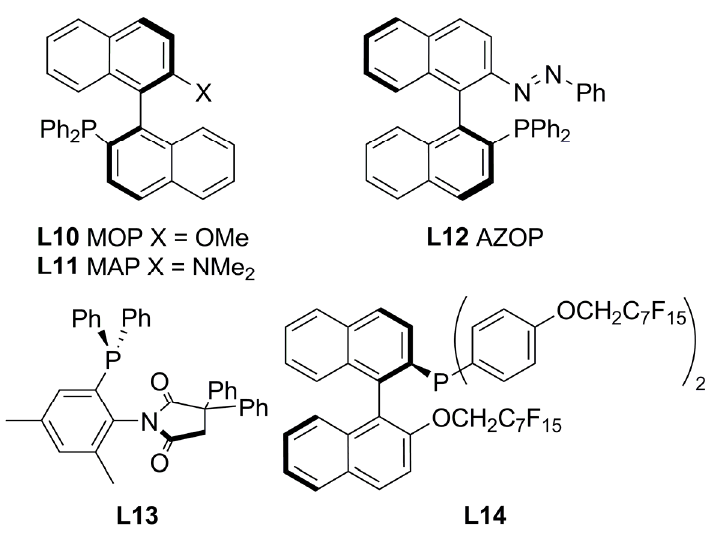
Figure 3. Monophosphine ligands with axial chiral.